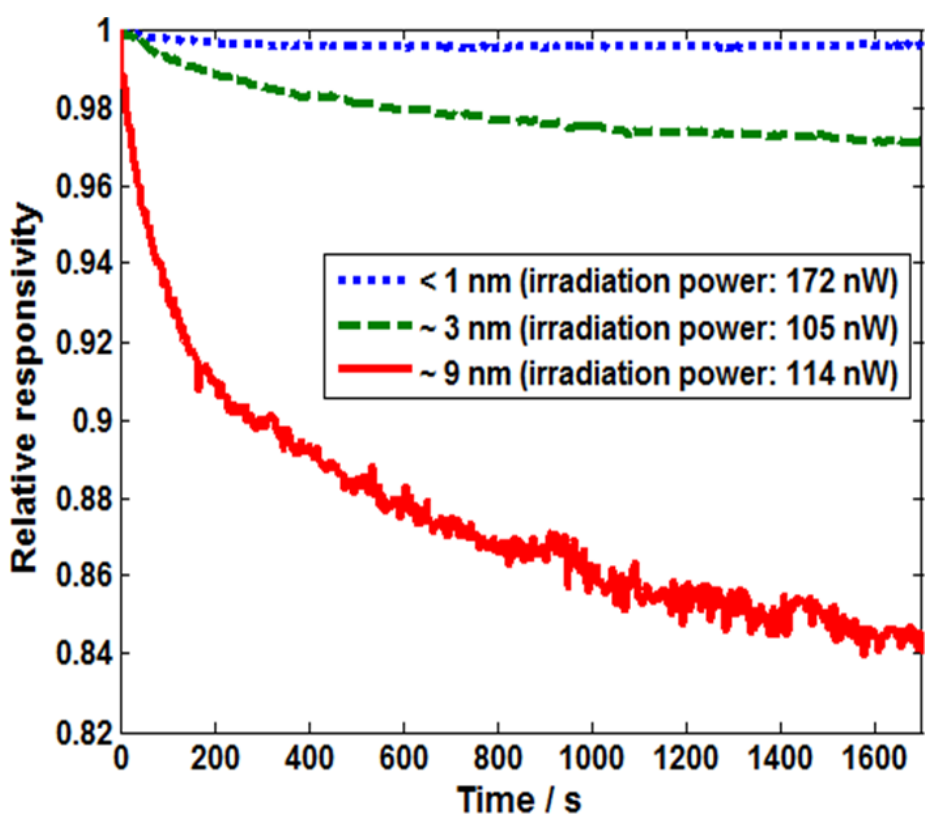
Figure 6. Responsivity degradation of 3 boron-silicon photodiodes with varying parasitic oxide content on the surface, at a 121-nm wavelength. The oxide content was measured by ellipsometry and is expressed as a thickness in nanometers